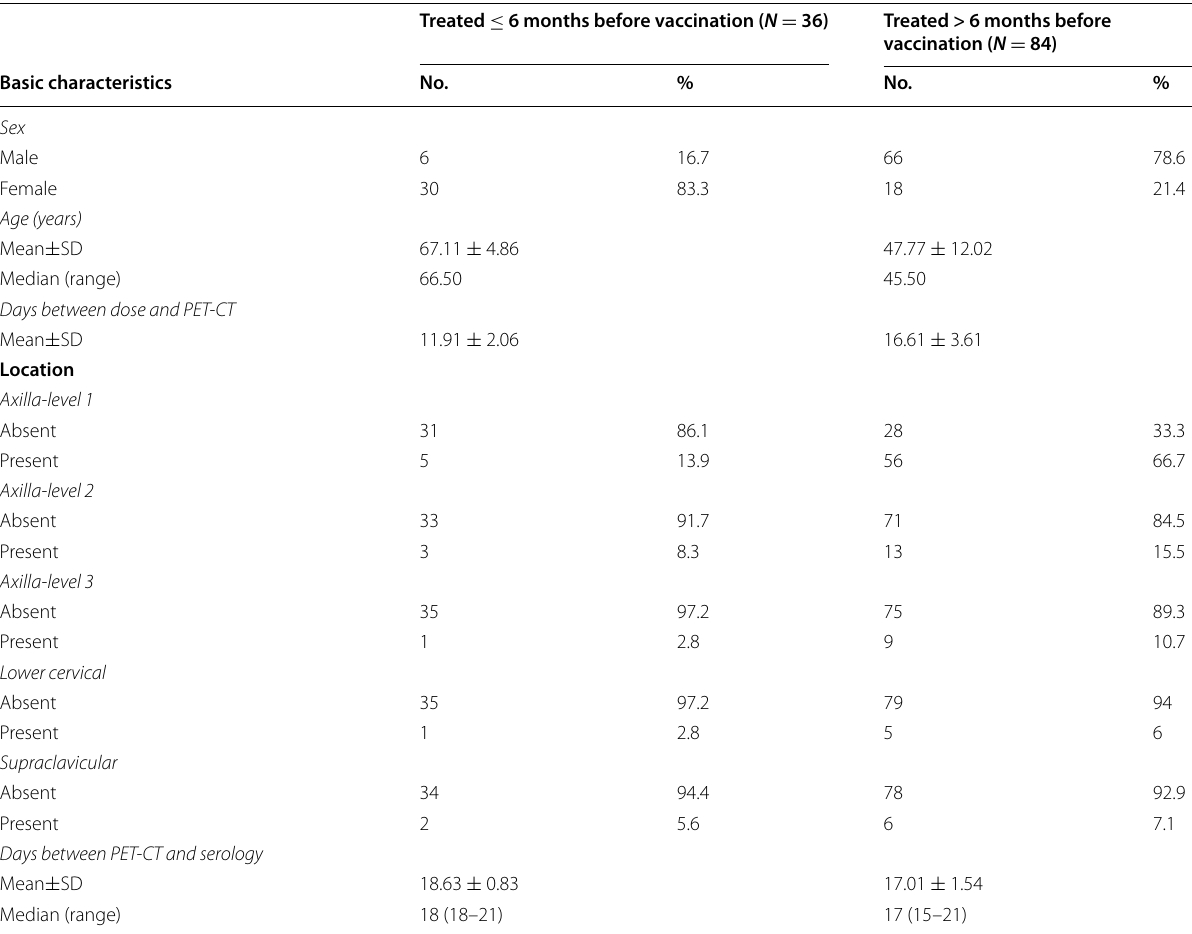
Table 1 Comparison between patients treated regarding basic